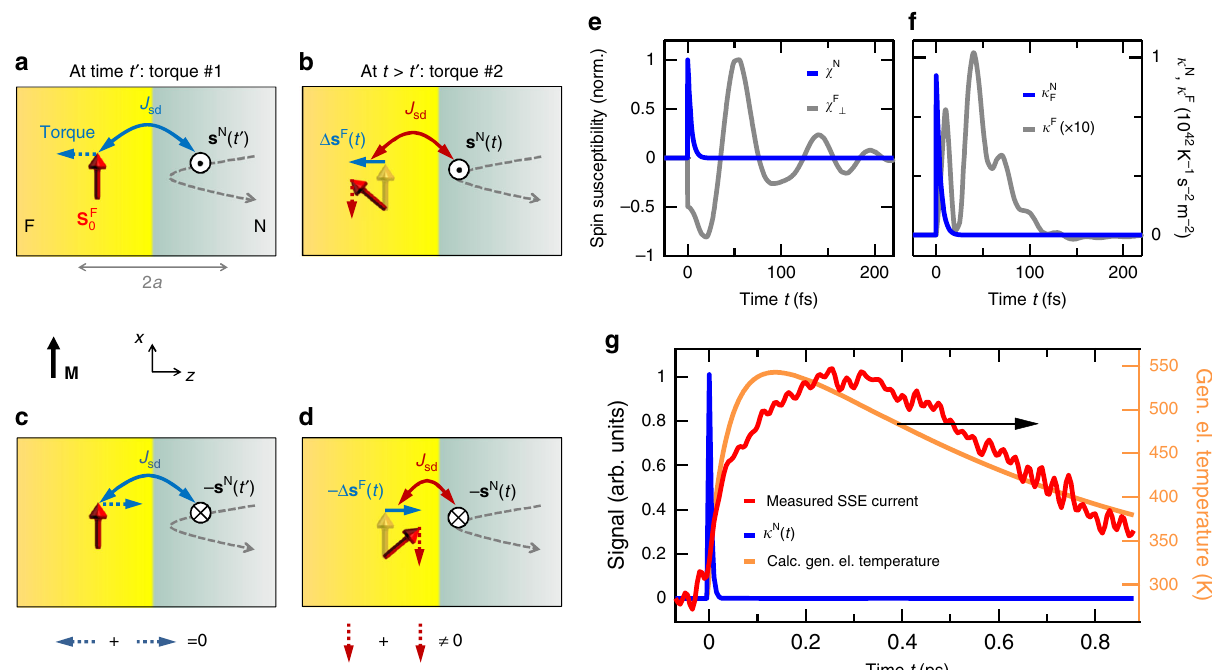
Fig. 5 Dynamic SSE model. a – d , Model schematic of the F|N interface. To illustrate the action of the exchange torque exerted by N on F, it is suf fi cient to consider the “ up ” ( (cid:5) , see panels a , b ) and “ down ” case ( ⊗ , see panels c , d ) of an N-cell spin fl uctuation s N perpendicular to the YIG magnetization M . a At time t ′ , an N electron entering the interaction region induces a fl uctuation s N t ′ ð Þ of the total N-cell spin, thereby exerting the effective magnetic fi eld J N t ′ ð Þ on the adjacent F-cell spin (torque #1). b Consequently, at a slightly later time t , the F-cell spin has changed by Δ s F t ð Þ proportional to J sd s c The opposite fl uctuation (cid:3) s N t ′ ð Þ at time t ′ induces d the change (cid:3) Δ s F t ð Þ , resulting in zero change in the F-cell spin, h Δ s F t ð Þi ¼ 0. However, as seen in panels ( b ) and ( d ), a second interaction at t > t ′ with the N-cell fi eld (torque #2) leads to the same recti fi ed torque J and, thus, a net spin current between F and N. e Calculated time-domain spin susceptibility of the F cell (transverse χ F ? t ð Þ of YIG) and the N cell (isotropic χ N t ð Þ of Pt). f Calculated dynamics of the SSE response functions κ N t ð Þ and κ F t ð Þ which quantify, respectively, the spin current induced by a δ t ð Þ -like temperature change of the N (Pt) and F (YIG) layer. The area under both curves equals the DC SSE constant K . g Evolution of the generalized electronic temperature of Pt as obtained by simulations based on the Boltzmann equation. Excitation conditions are similar to those used in the experiment. For direct comparison, the measured spin current j s ( t ) (see Fig. 4b) and calculated SSE response function κ N t ð Þ (see panel f ) are also